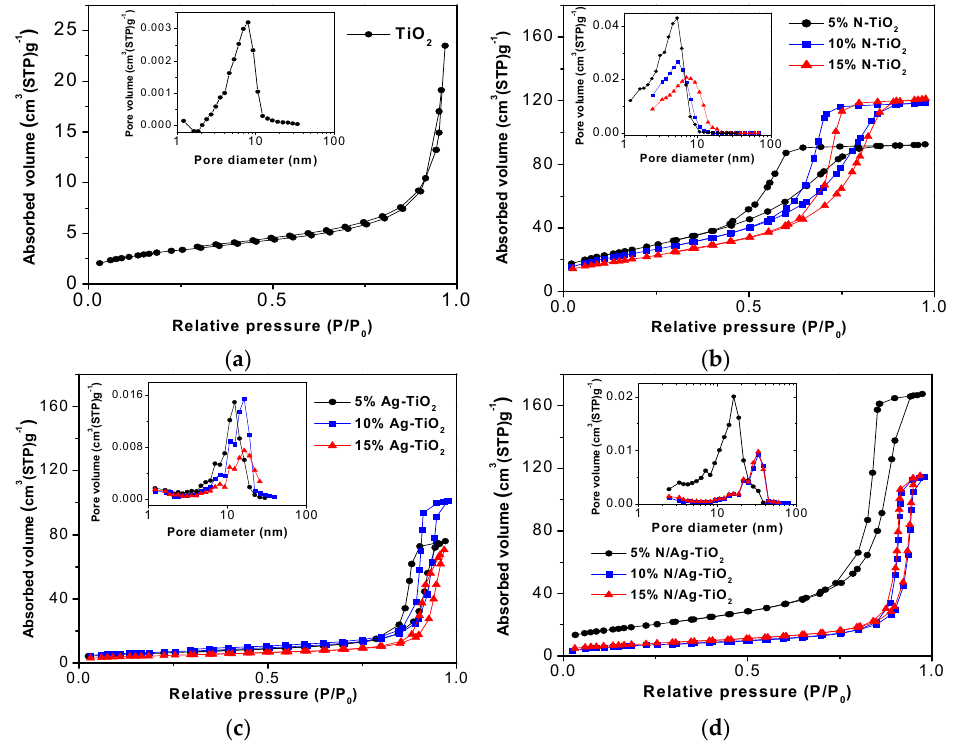
Figure 2. N 2 adsorption-desorption isotherm and the BJH pore size distribution (inset) of ( a ) undoped TiO 2 , ( b ) N-TiO 2, ( c ) Ag-TiO 2 , and ( d ) N/Ag-TiO 2 with different dopant loadings (5%–15% mol). Table 1. Characteristic information and photocatalytic performance of MB degradation under visible LED irradiation in 6 h of different prepared photocatalysts, including the data for MB degradation by photolysis without a catalyst.